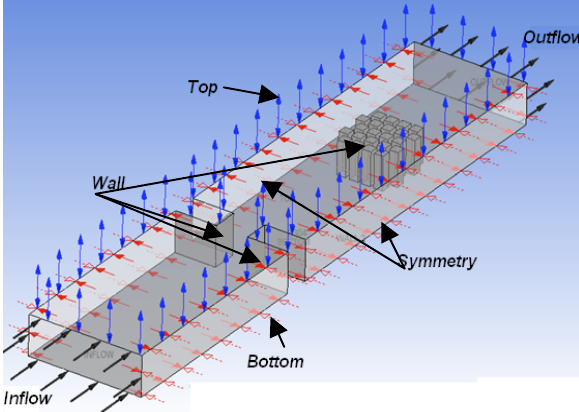
Fig. 2. Calculation domain showing 3D boundary conditions